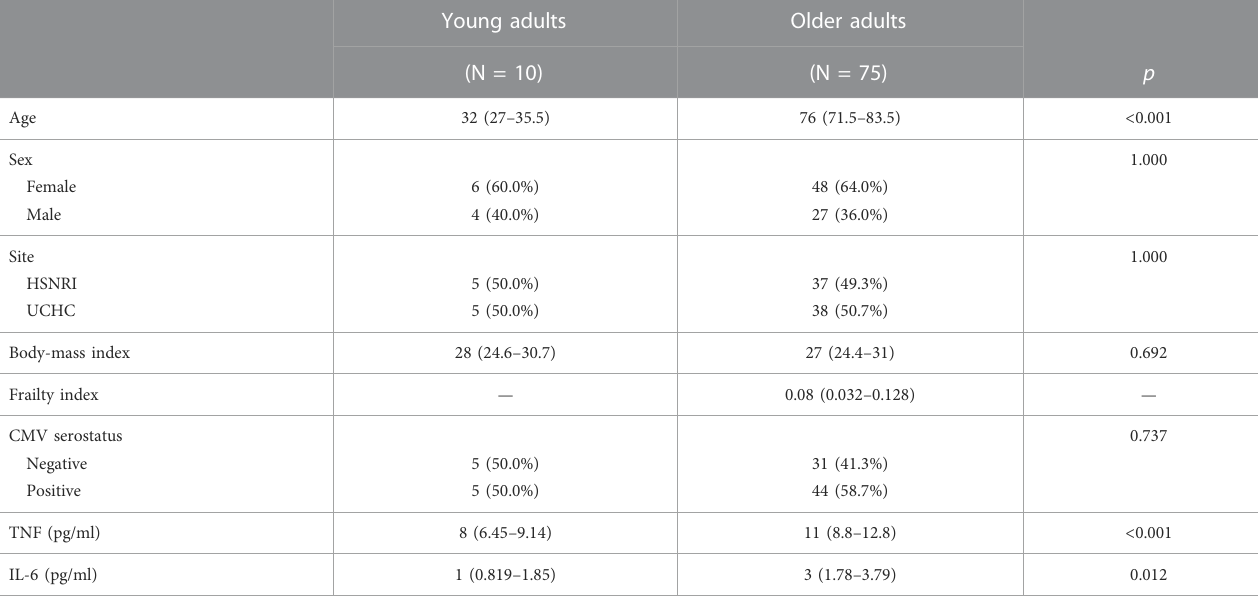
TABLE 1 Summary of demographics and health-related traits in young and older